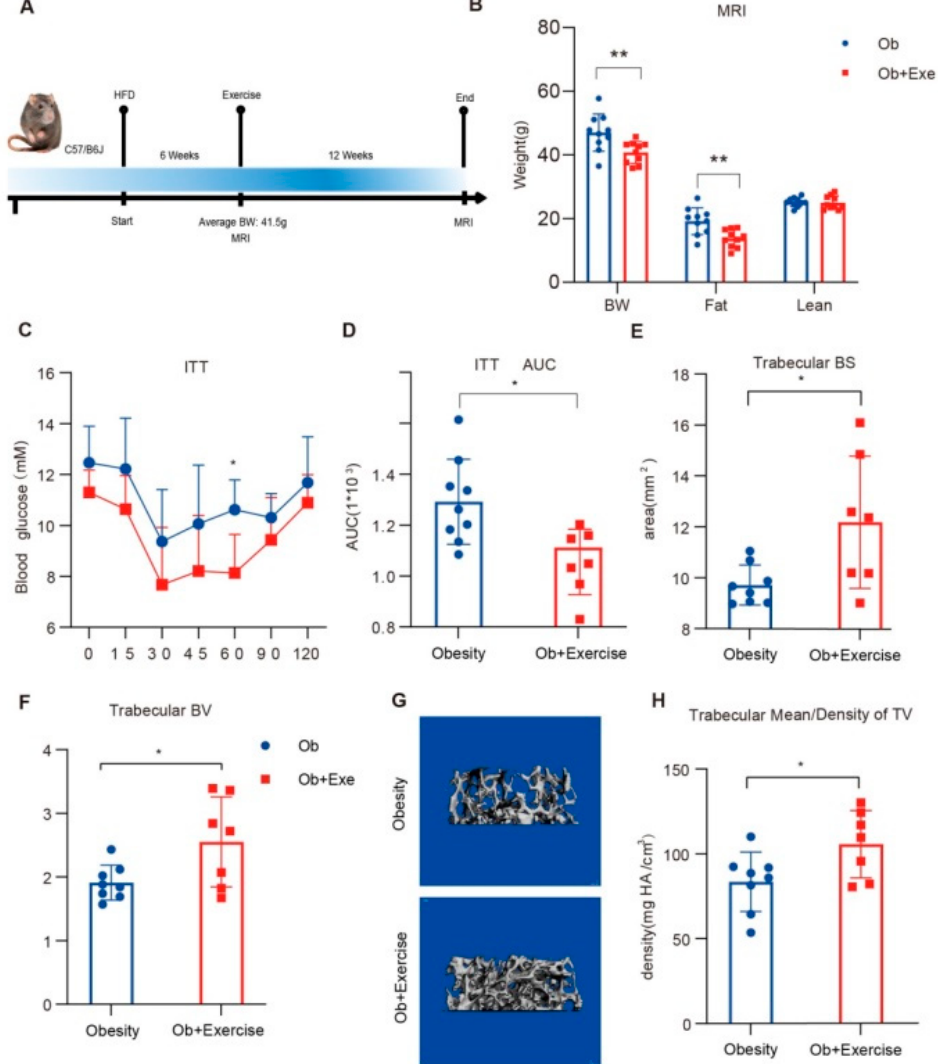
Figure 1. Exercise improved insulin sensitivity and bone density. ( A ) The eight-week-old male C57/B6 mice were fed with HFD for 6 weeks. The average body weight of the mice achieved 41.5 g after 6 weeks of HFD and before the mice started the 12-week treadmill running with HFD. Body composition was measured before and after exercise intervention. ( B ) Body composition was measured after exercise in the obesity and exercise groups using MRI. ( C , D ) measurement of plasma glucose during ITT and the AUC of the obesity ( N = 9) and exercise ( N = 7) groups after 8-week treadmill exercise. ( E , F ) femoral BS, BV in the trabecular regions of TV. ( G ) representative trabecular reconstruction image of the femur by µCT. The gray part of the picture shows reconstructed trabecular bones. ( H ) femoral bone density in the trabecular regions of TV. * p < 0.05, ** p < 0.01 2-sided Student t test. Data are presented the mean ± SD. AUC, areas under the curve; BW, body weight; HFD, high fat diet; ITT, insulin tolerance test; MRI, magnetic resonance imaging.